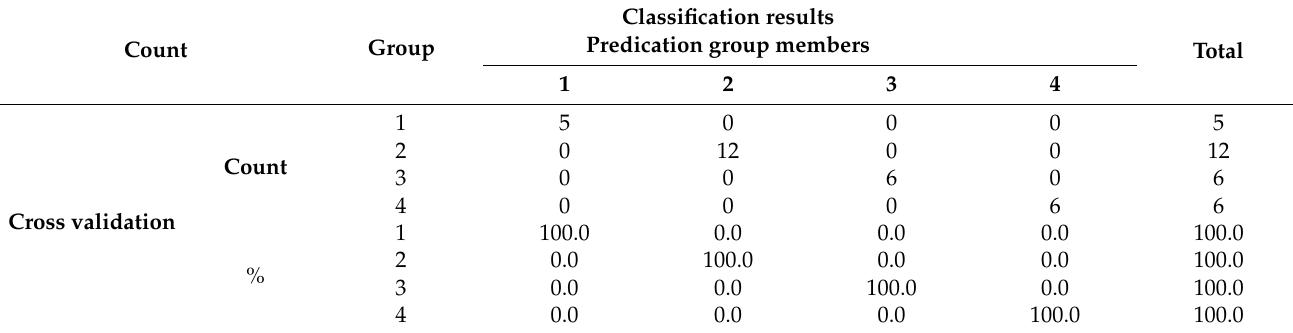
Table 4. Original and cross verification of Fisher’s discrimination function.